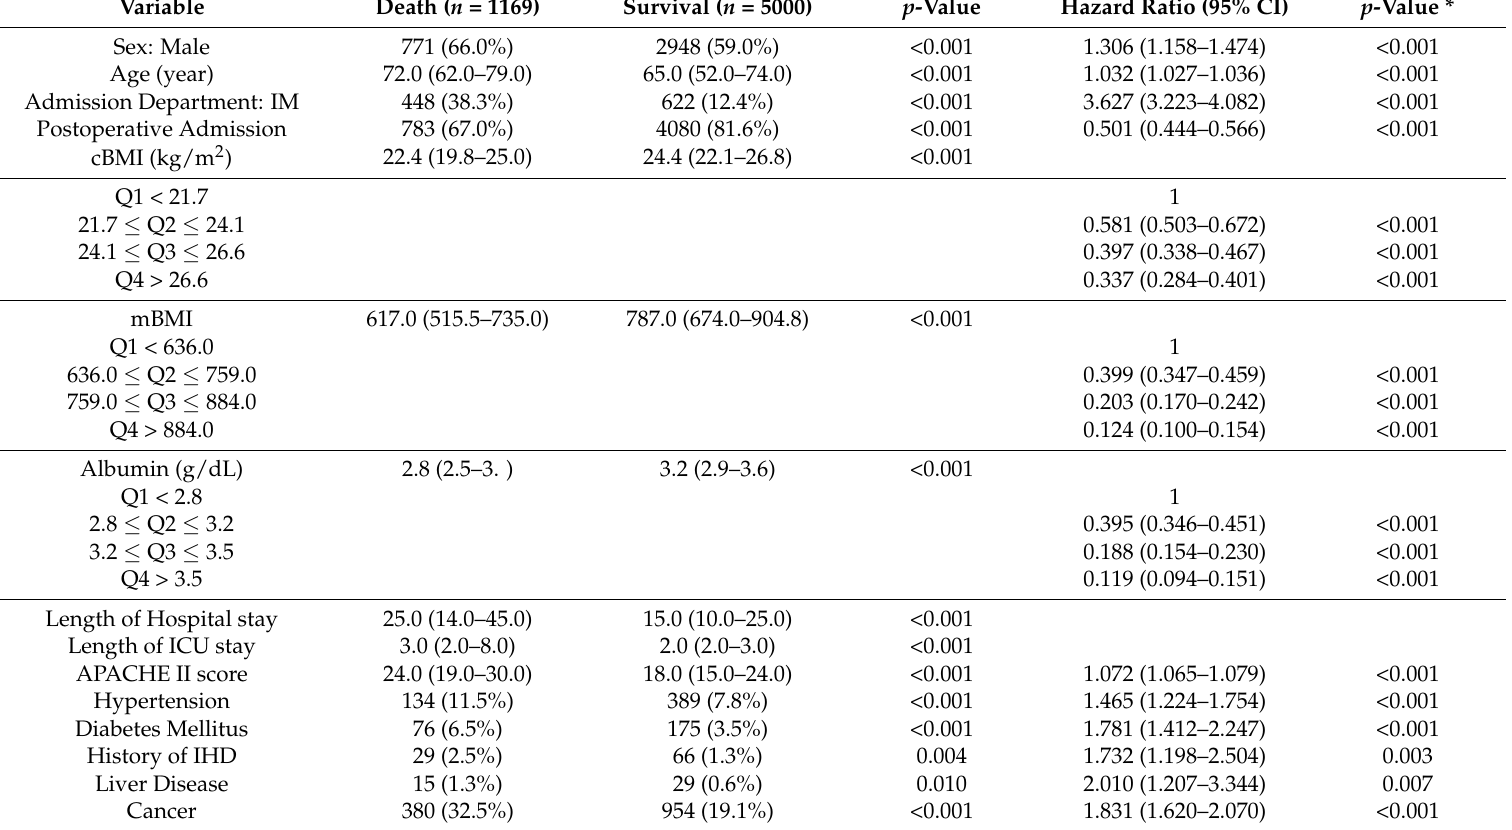
Table A2. Univariate Cox Regression Analysis for 1-year Mortality after ICU